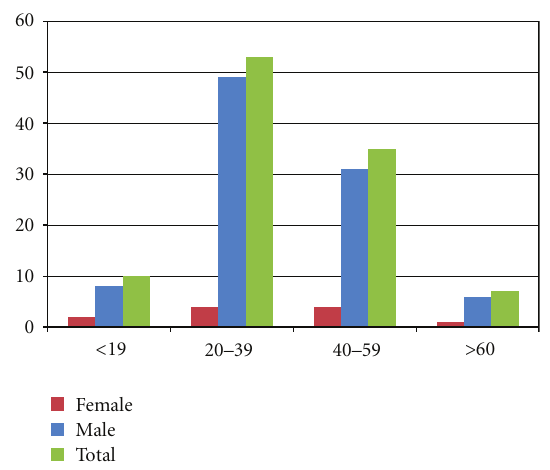
F 2: Distribution of patients for age groups and gender. 50.5 of all dislocations (53 cases) occurred in individuals between the ages of 20 and 39